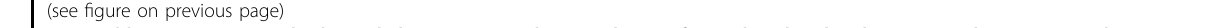
Fig. 6 Old CTC KI/Cre mice display a slight intraneuronal accumulation of Tau phosphorylated at S202 and S396/404, and rare argentophilic deposits in the CA1. a Representative micrographs of 25-month-old CTC KI/Cre, CTO KI/Cre, or AD brain hippocampus tissue sections immunostained with AT8 (pTauS202/T205), RZ3 (pTauT231), pTauS422, and MC1 (pathologic Tau conformation) antibodies. b Representative micrographs of 25-month-old CTC and CTO KI/Cre, WT/WT, or 14-month-old 3xTgAD hippocampus tissue sections immunostained with CP13 (pTauS202) and PHF1 (pTauS396/404) antibodies. c Quanti fi cations of the number of CP13 or PHF1 immunopositive cells per μ m of in the CA1 PCL of 25-month-old CTC and CTO KI/Cre, CTC, and CTO KI/WT, WT/Cre or WT/WT ( n = 3/genotype). Data represent the mean ± SEM. Statistical evaluations were done with one-way ANOVA followed by a Bonferroni ’ s post-hoc analysis. d Representative micrographs of Bielschowsky silver staining of 18- and 25-month-old CTC and CTO KI/Cre, or WT/WT hippocampus tissue sections (18 M: n = 4/genotype, 25 M: n = 3/genotype). Hc